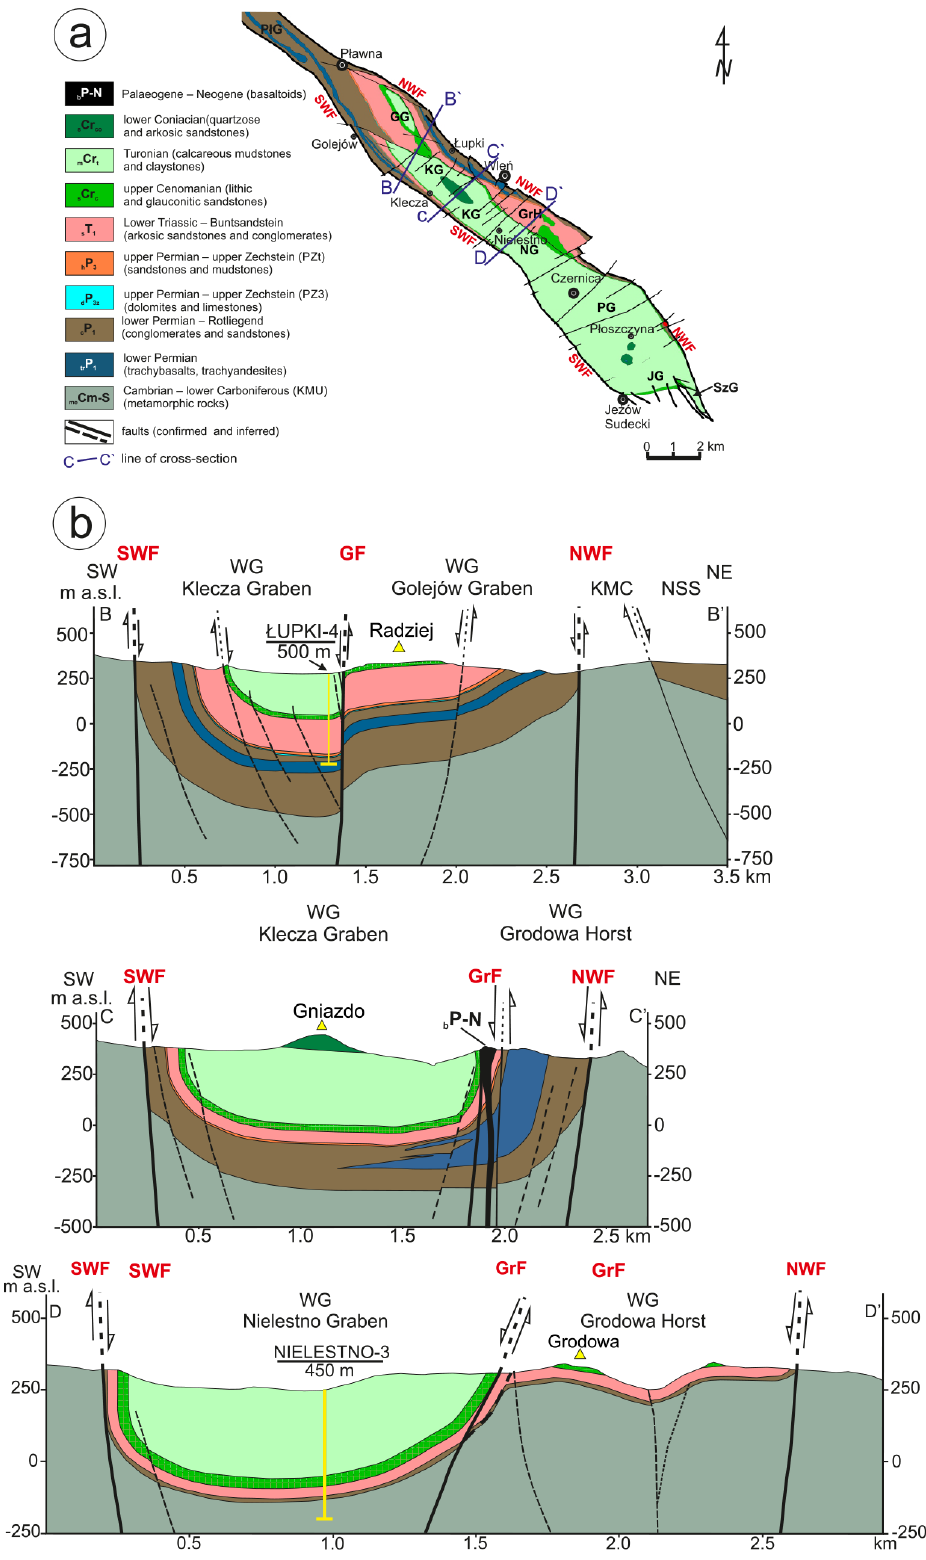
Figure 10. Simplified geological map and three selected cross-sections of the Wle´n Graben according to Kowalski (2021).